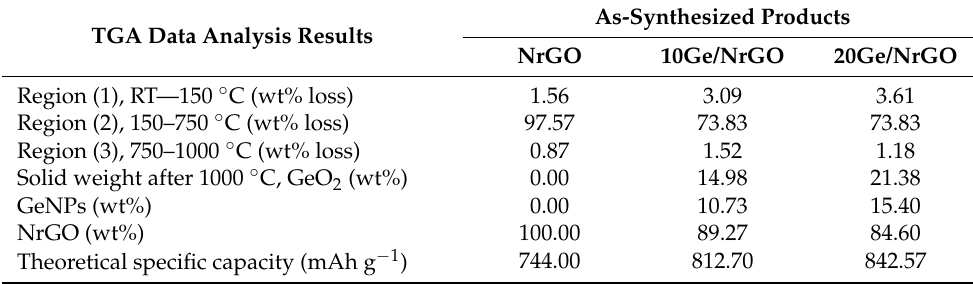
Figure 8. The TGA analysis curves of as-synthesized products. Table 1. The results of TGA data analysis for content determination and theoretical specific capacity calculation.